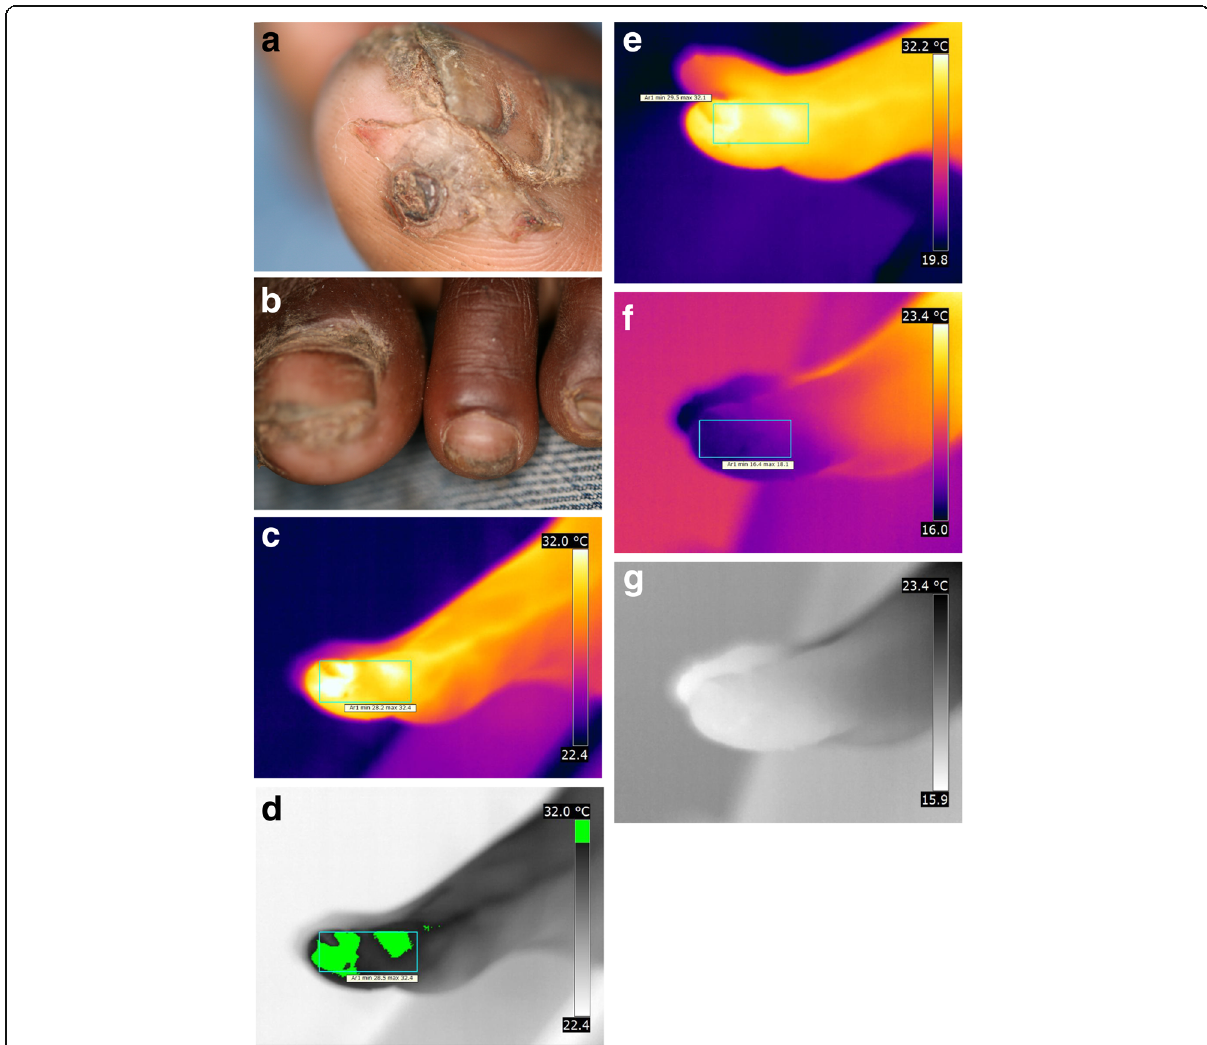
Fig. 6 ( a ) left foot, multiple stage II and IIIb lesions together with hyperpigmentation and hyperkeratosis. ( b ) left foot, stage II lesion on the proximal medial edge of the second toe. ( c ) left foot, perilesional hyperthermia with a median of 31.0 °C (iron transformation). ( d ) left